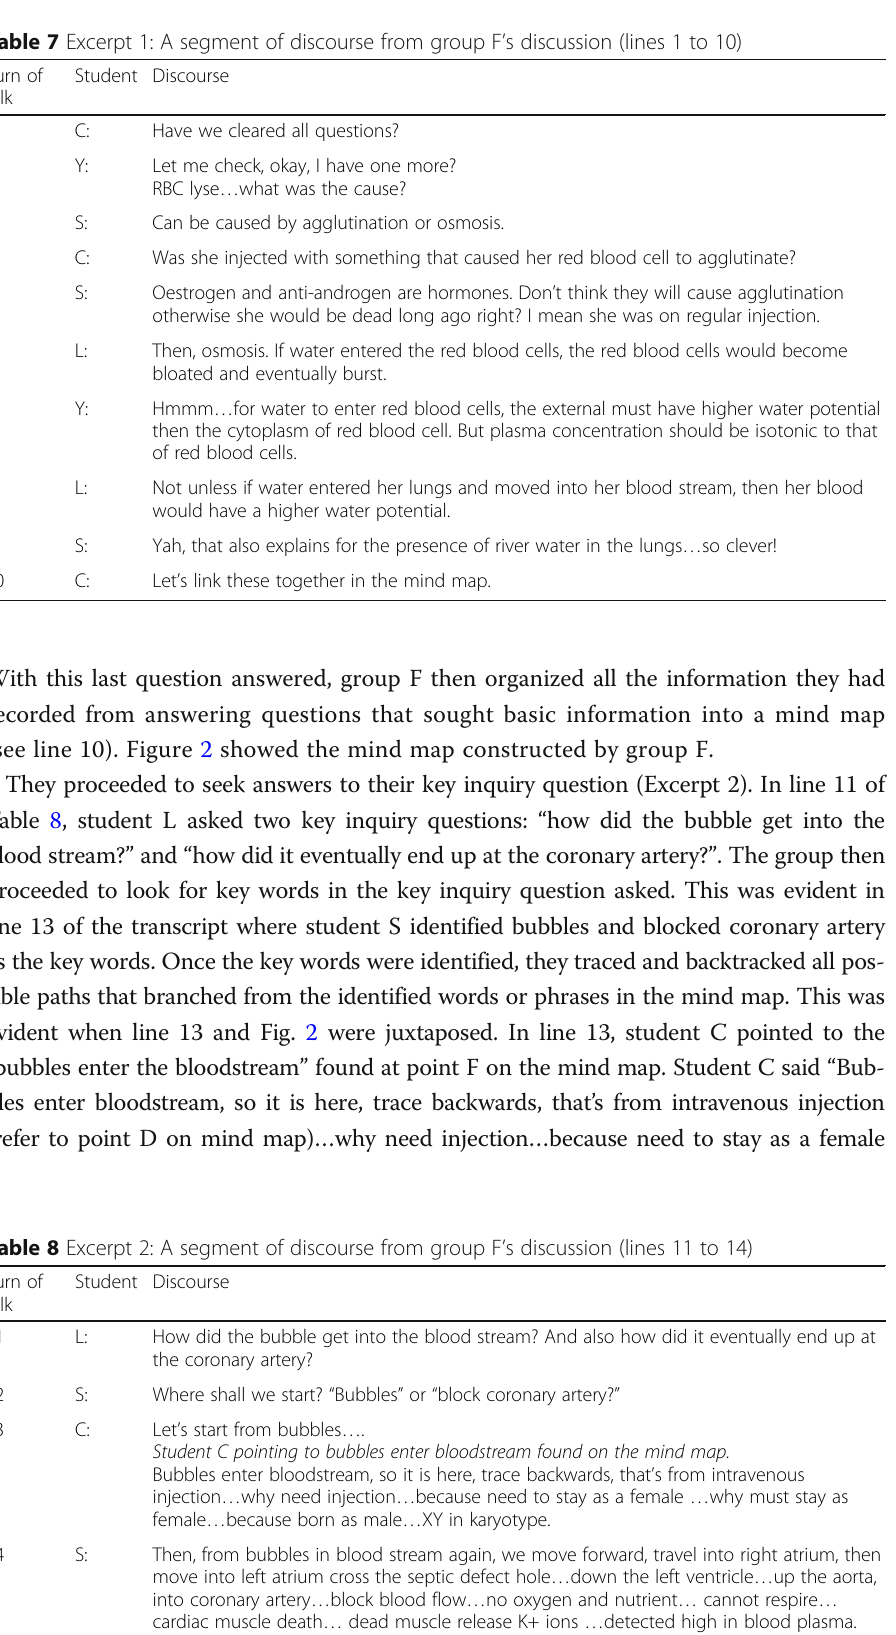
Table 7 Excerpt 1: A segment of discourse from group F ’ s discussion (lines 1 to 10) Turn of talk